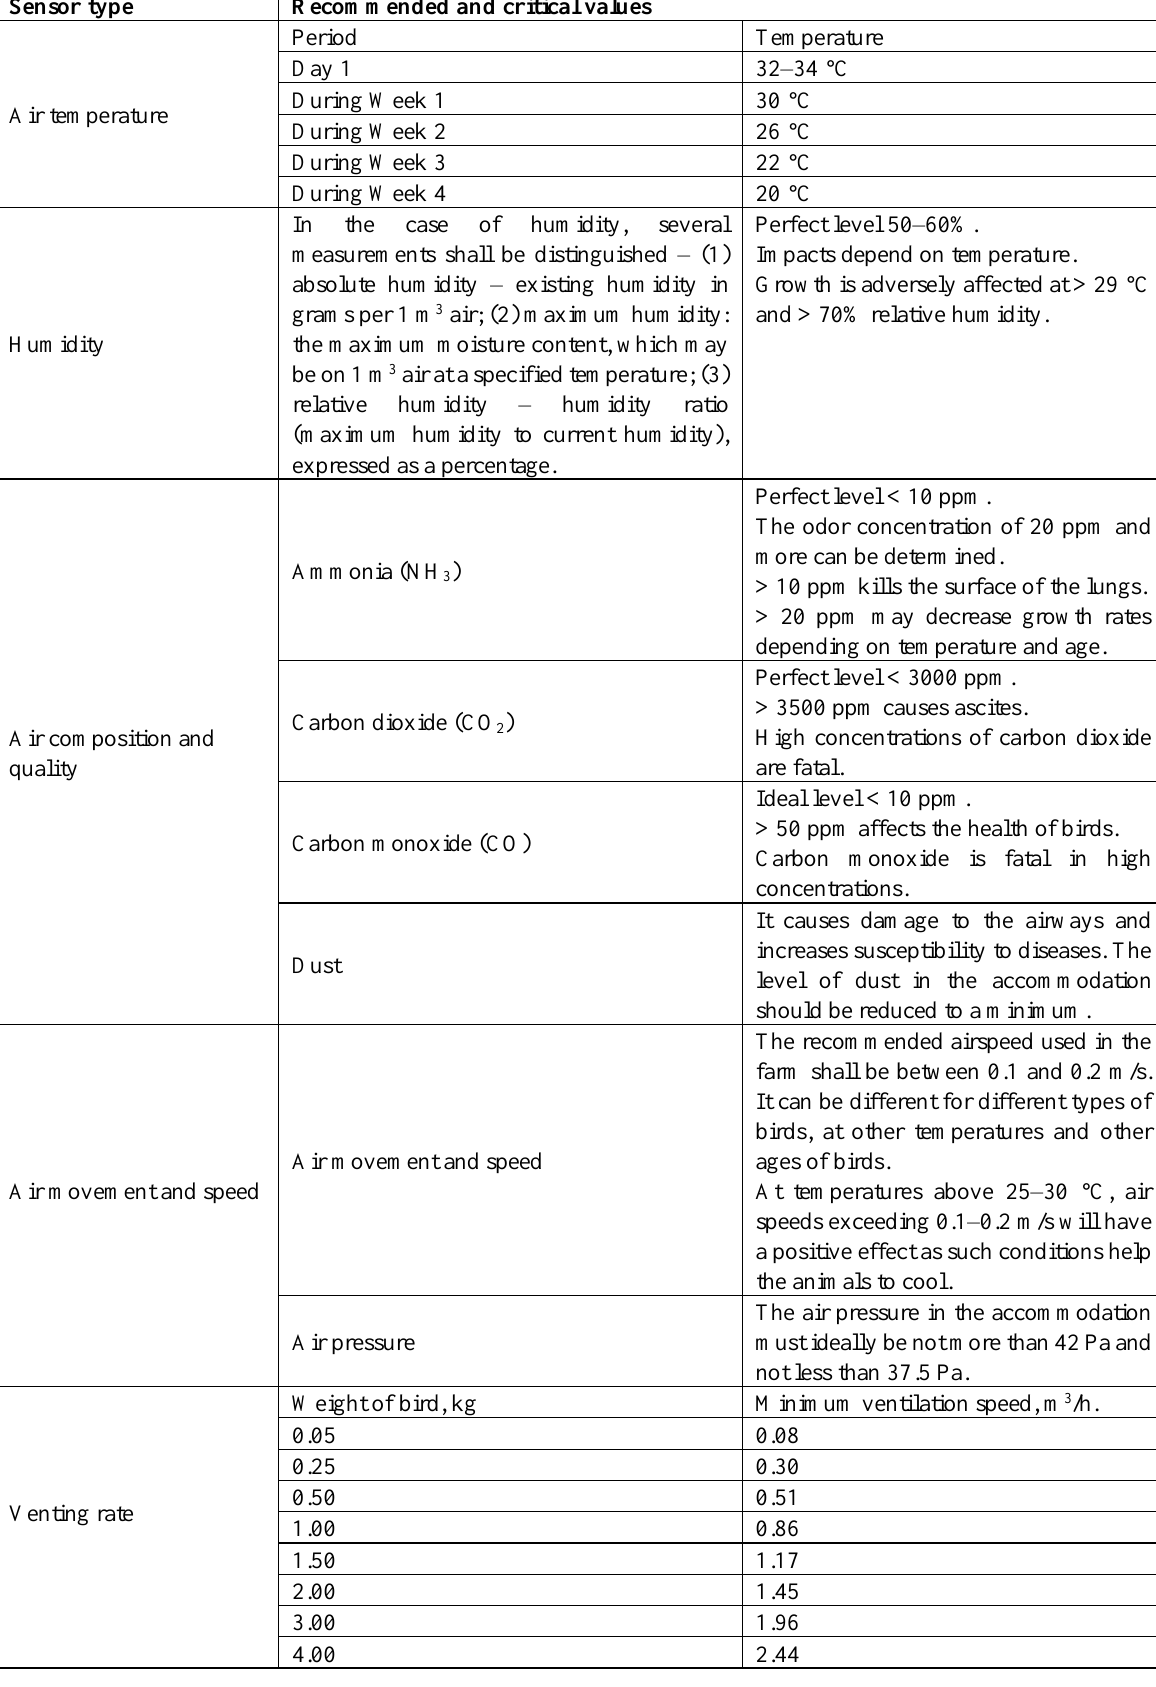
Table 2. Recommended values of environmental indicators [10], [11],